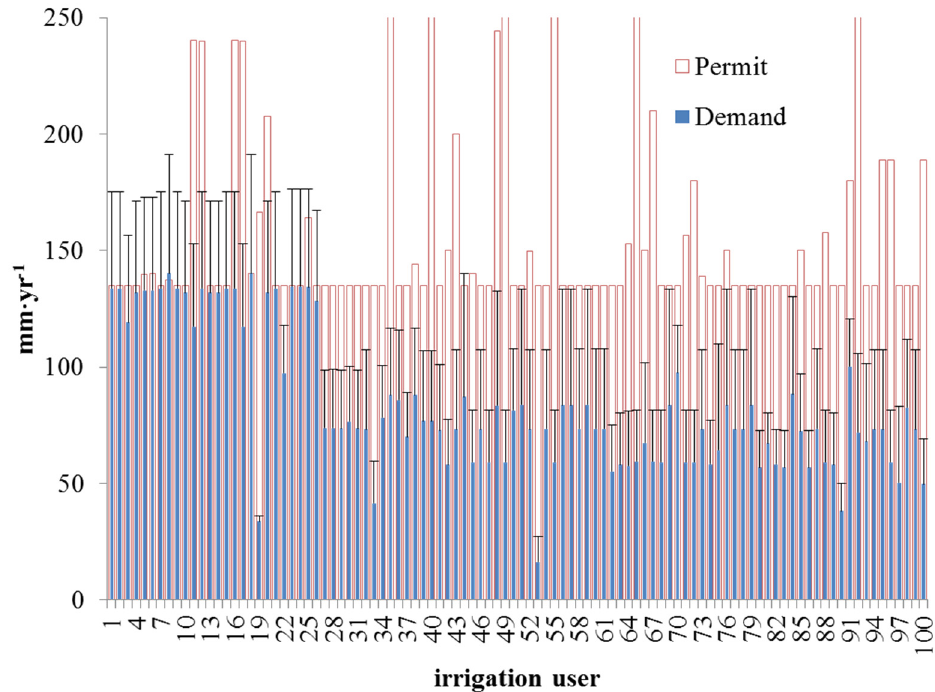
Figure 7. Comparison of (red) irrigation permits and (blue) calculated average irrigation water demands (whiskers: 10th percentile) of each agricultural irrigation user of the simulation area in reference projection